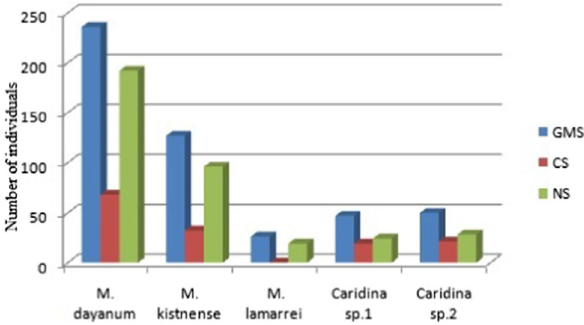
Fig. 2 Diversity and abundance of different species of prawns col- lected from Gho Manhasa, Chadwal and Nagri